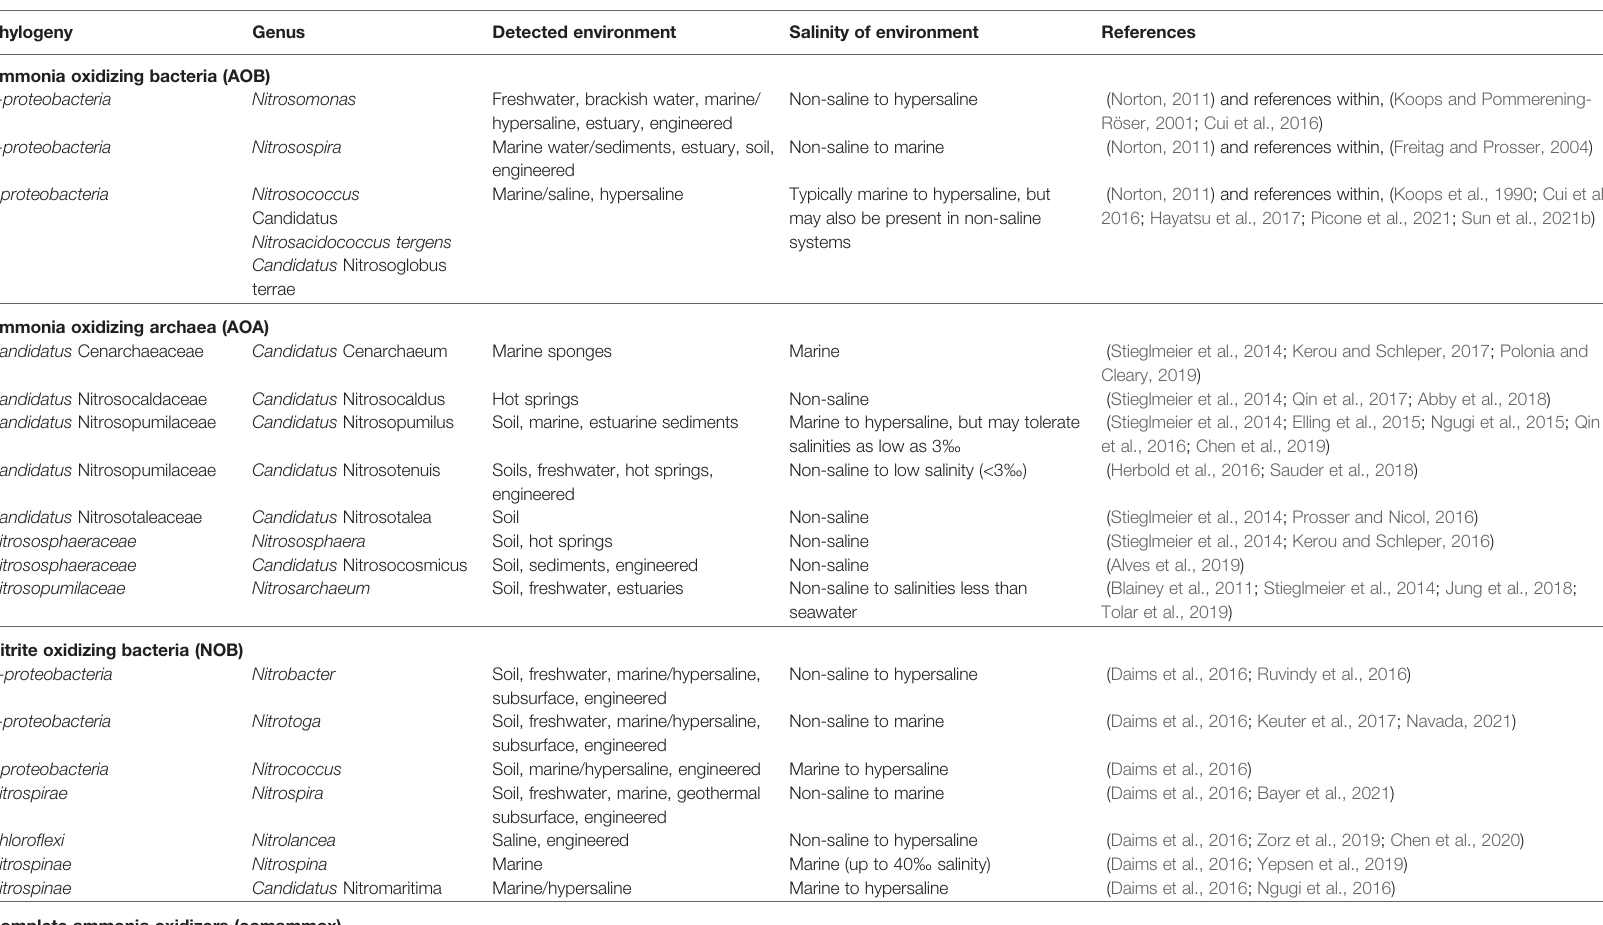
TABLE 1 | Environmental distribution and salinity of environment for genera of ammonia oxidizing bacteria (AOB), ammonia oxidizing archaea (AOA), nitrite oxidizing bacteria (NOB) and comammox